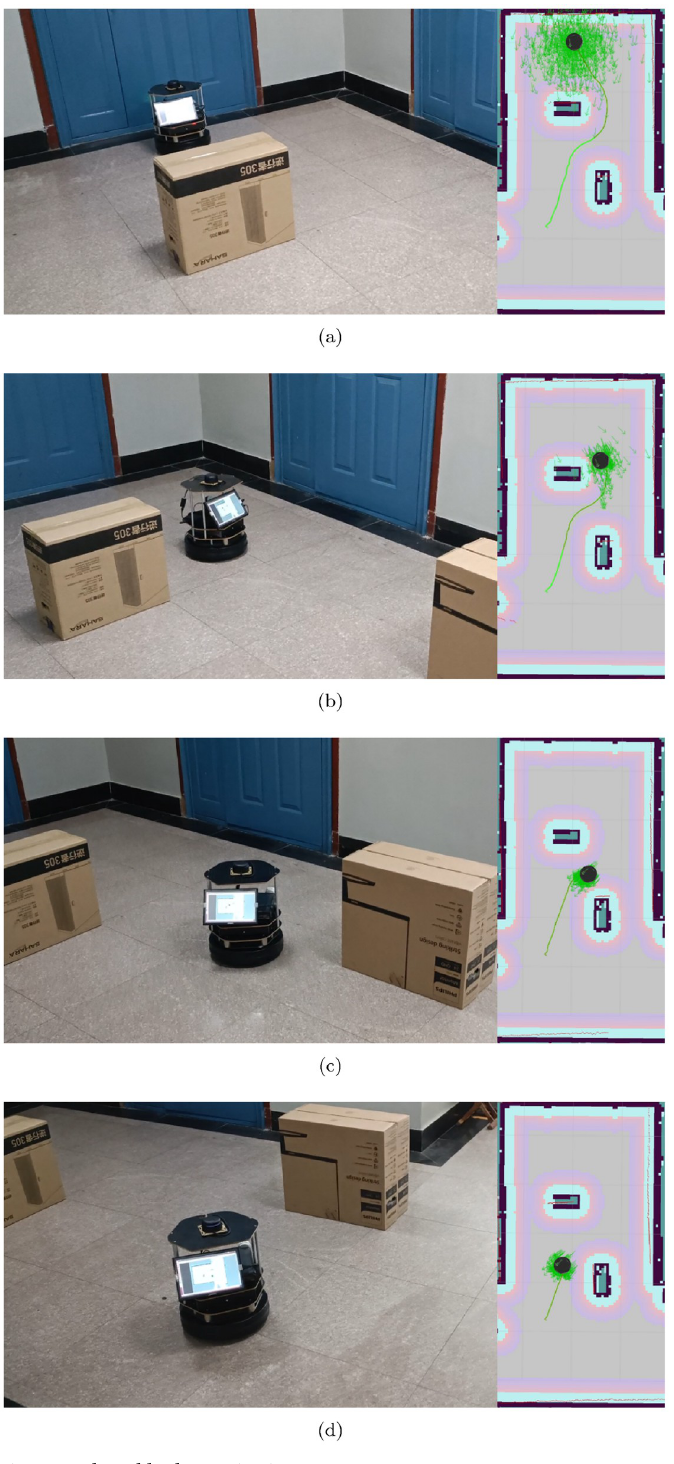
Fig 10. Real-world robot